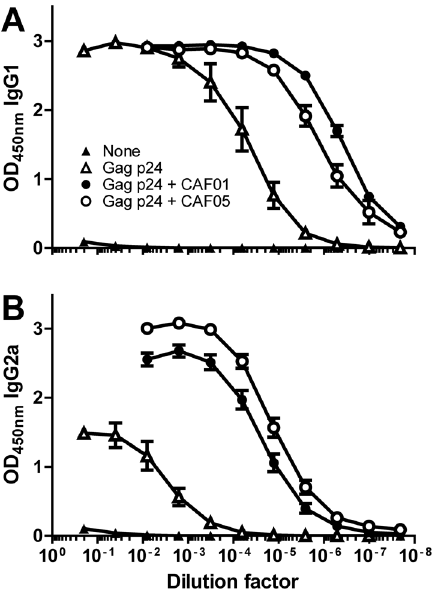
Figure 2. CAF05 enhances Gag p24 specific antibodies to the same level as CAF01. Mice were immunized three times i.p. with 20 m g Gag p24 protein alone (open triangles) or adjuvanted in either CAF01 (black circles) or CAF05 (open circles). Naı¨ve mice were used as a negative control (black triangles). Three weeks after the final immunization, antigen-specific IgG1 (A) and IgG2a (B) antibody responses in serum from individual mice were determined ELISA. Each data point represents the mean (n=6) + / 2 SEM.